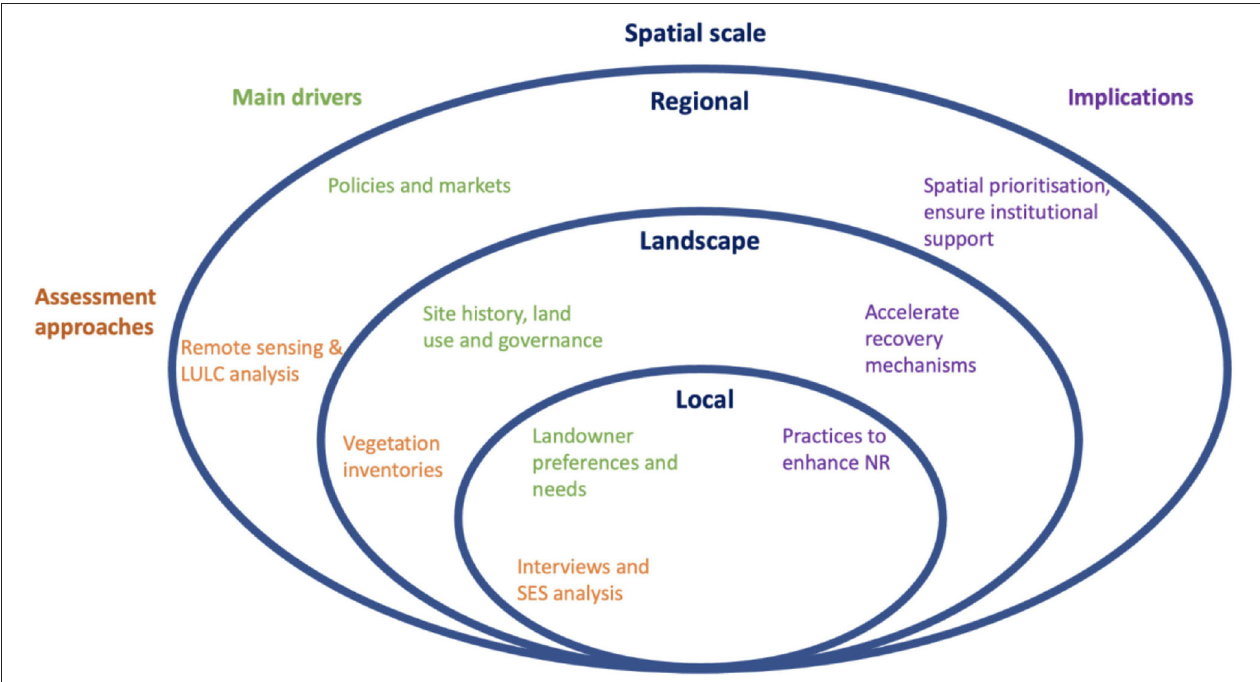
FIGURE 1 | Different spatial scales at which the role of natural regeneration for restoration was assessed, the associated assessment approaches, the main drivers that influenced its success and the implications for restoration. LULC, Land Use and Land Cover; SES, Social-Ecological Systems; NR, natural